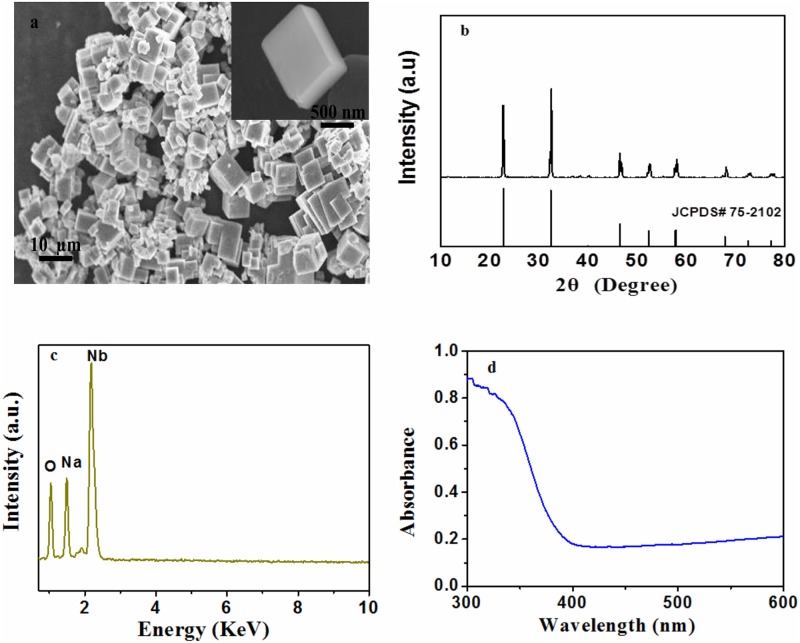
Characterization data of NaNbO3.(a) FESEM images of NaNbO3. (b) XRD pattern of NaNbO3. (c) EDX pattern of NaNbO3. (d) DR-UV-visible spectrum of NaNbO3.